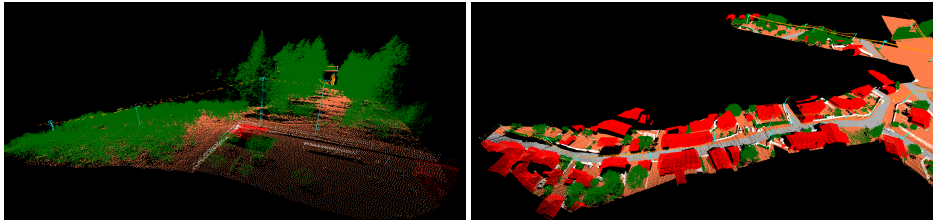
Figure 2. Examples of forest area and urban area in